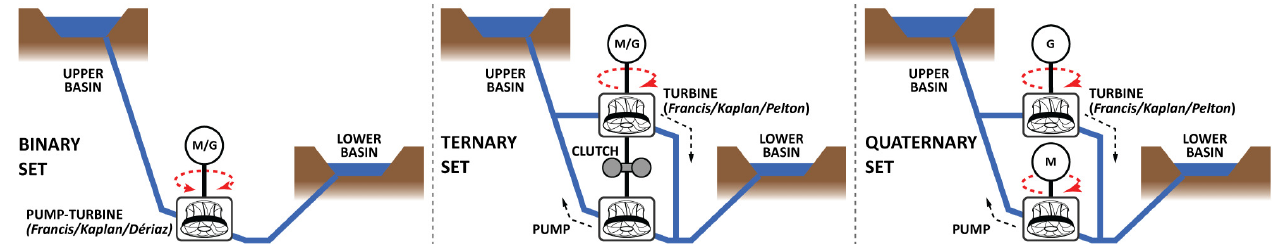
Figure 2. Classification of the configuration of the PHS Plant based on the number and arrangement of the different machines (pumps/turbines) of which the system is composed: Binary, Ternary, and Quaternary